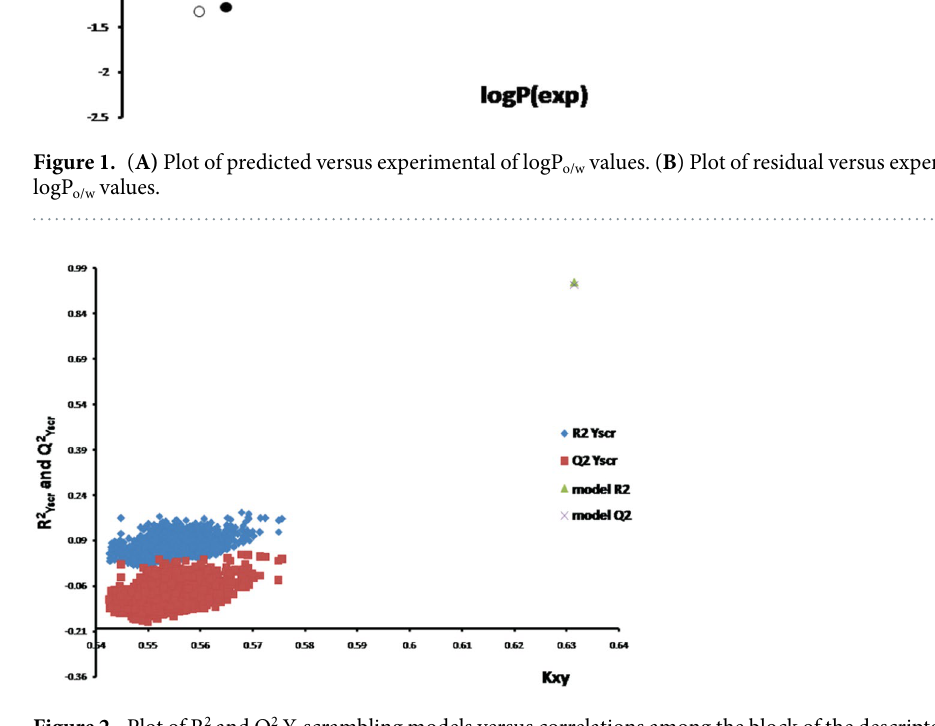
Figure 2. Plot of R 2 and Q 2 Y-scrambling models versus correlations among the block of the descriptors and the experimental data